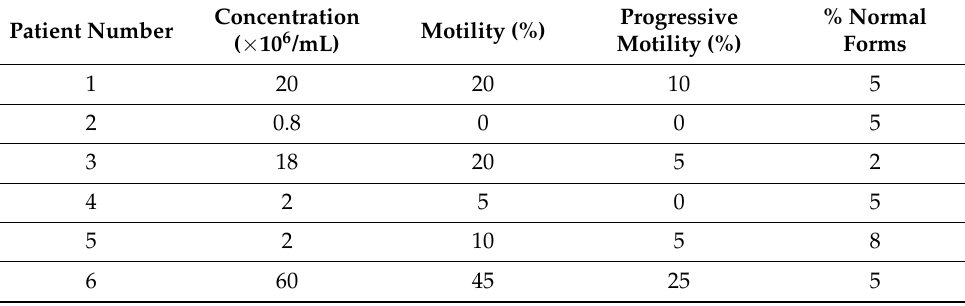
Table 2. Infertile cohort semen parameters assessed by a trained andrologist. Concentration Patient Number Motility ( × 10 6 /mL)